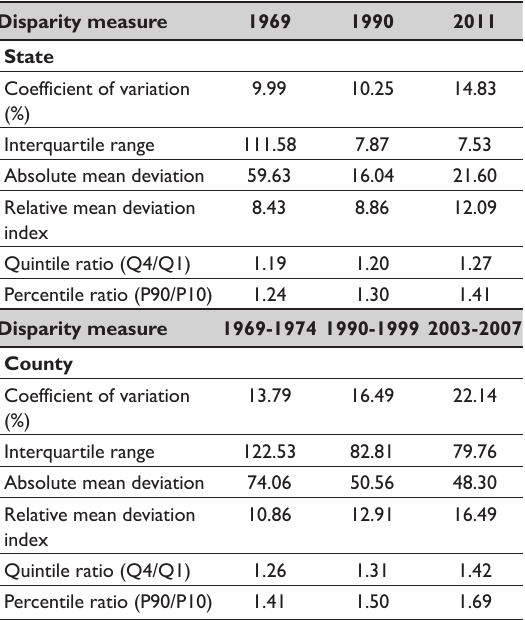
Table 4. Summary Measures of Geographical Disparities in Cardiovascular Disease (CVD) Mortality, United States, 1969-2011 (50 States and District of Columbia;